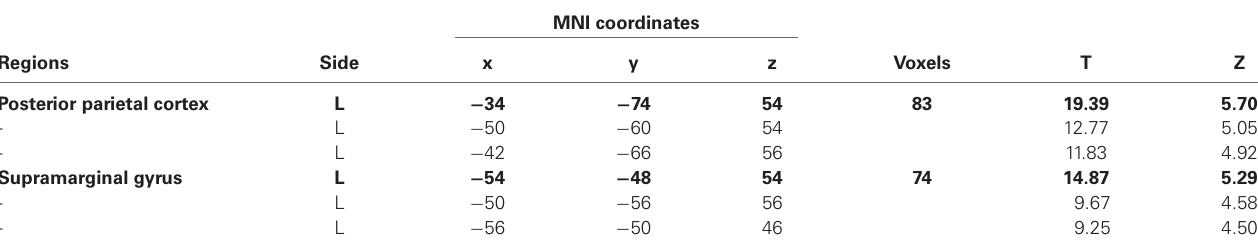
Side indicates hemisphere (R = right, L = left), cluster size indicates N voxels, T indicates peak t-values, Z indicates peak z-values. Entries without brain region name labels indicate sub-peak within the cluster named